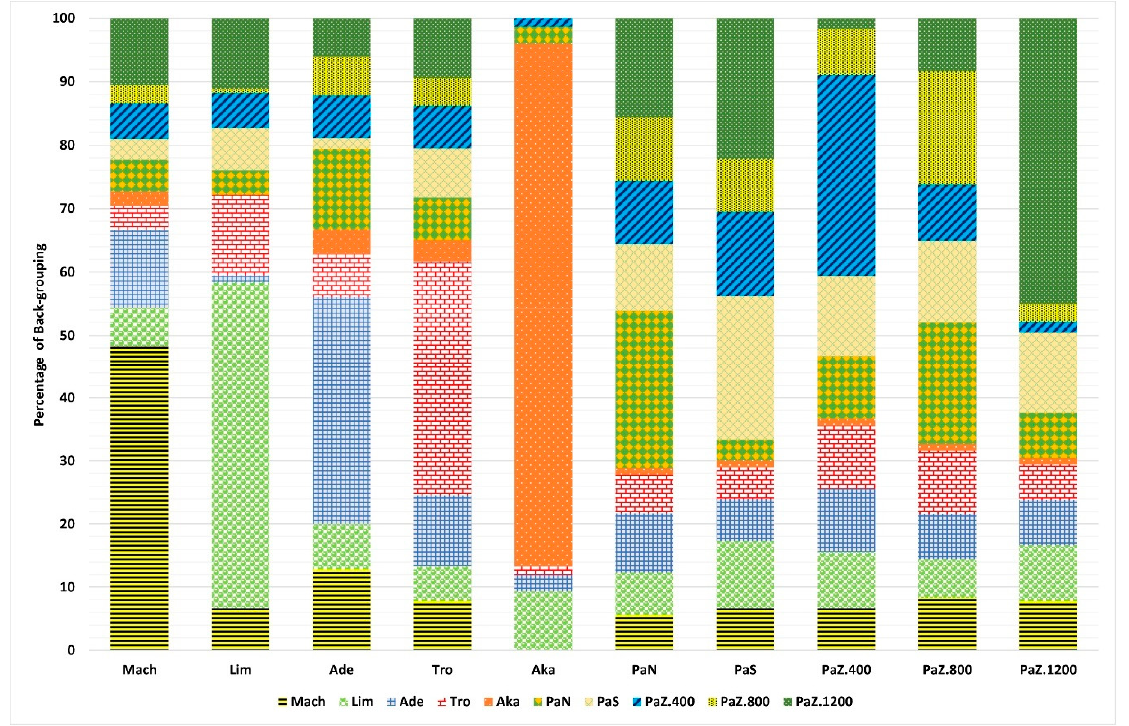
Figure 6. Back-grouping (classification) results of the morphoanatomical traits, using the sampling locations as a dependent variable.